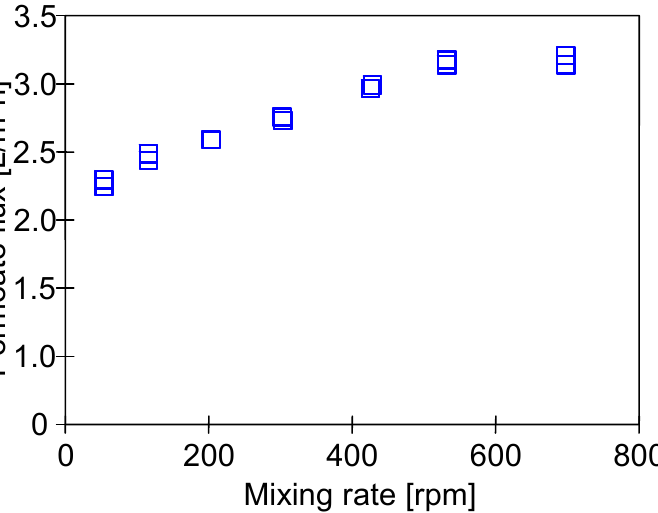
Figure 6. The impact of the stirrer rotational speed on the M#3 module. Feed: NaCl solution (35 g/L). T F = 60 °C.